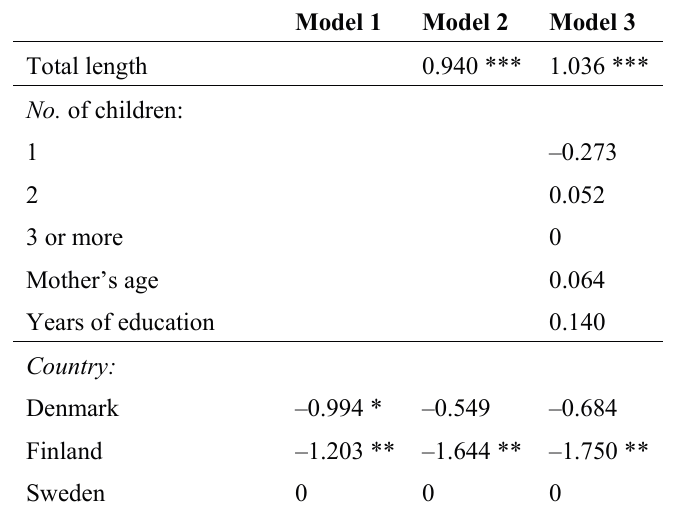
Table 6. Perceived negative career consequences related to full-time care at home for mothers in Denmark, Finland, and Sweden with the youngest child over 6 years old a